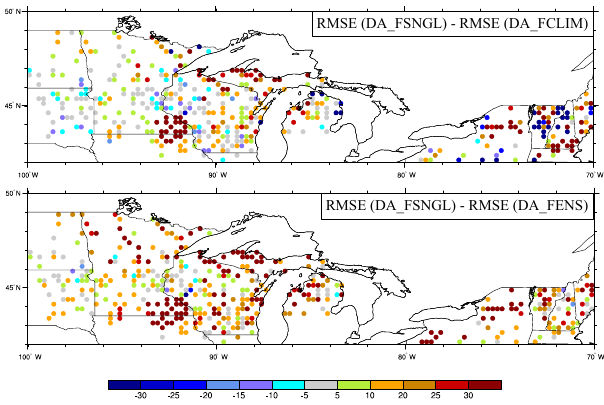
Figure 5. RMSE (mm) differences of snow depth fields from DA integrations using hybrid ensemble forcing strategies (DA_FCLIM and DA_FENS) relative to the DA integration using a single forcing (DA_FSNGL) over the Great Lakes domain, using GHCN data as the reference, for the time period of 2012 to 2015. Warm colors in- dicate locations where DA_FCLIM or DA_FENS provides a lower RMSE than DA_FSNGL and cool colors indicate locations where DA_FSNGL has a lower RMSE than DA_FCLIM or DA_FENS.